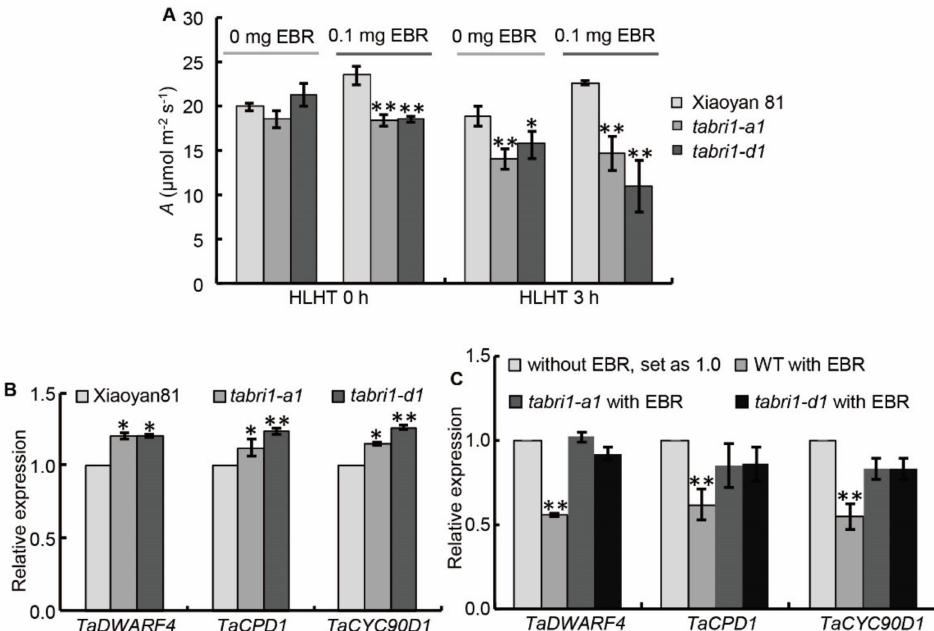
Figure 10. E ff ects of EBR on CO 2 assimilation rate and BR-related gene expression of TaBRI1 mutants under both HLHT 0 h and 3 h. ( A ) E ff ects of EBR on CO 2 assimilation rate, A, of WT and TaBRI1 mutants under HLHT 3 h. Data from three biologic replicates, and each biologic replicate comprised eight plants. * and ** indicate significant di ff erences between WT and TaBRI1 mutants at p < 0.05 and p < 0.01, respectively; ( B ) expression of BR biosynthetic genes in WT and TaBRI1 mutants. Gene expression levels in WT are set as 1.0. Data from three biologic replicates, and each biologic replicate comprised a pool of five plants. * and ** indicate significant di ff erences between WT and TaBRI1 plants at p < 0.05 and p < 0.01, respectively; ( C ) expression of BR biosynthetic genes in WT and TaBRI1 mutants with or without EBR treatment. Gene expression levels in WT without EBR treatment are set as 1.0. Data from three biologic replicates, and each biologic replicate comprised a pool of five plants. ** indicate significant di ff erences between the control and EBR treated plants in WT at p <